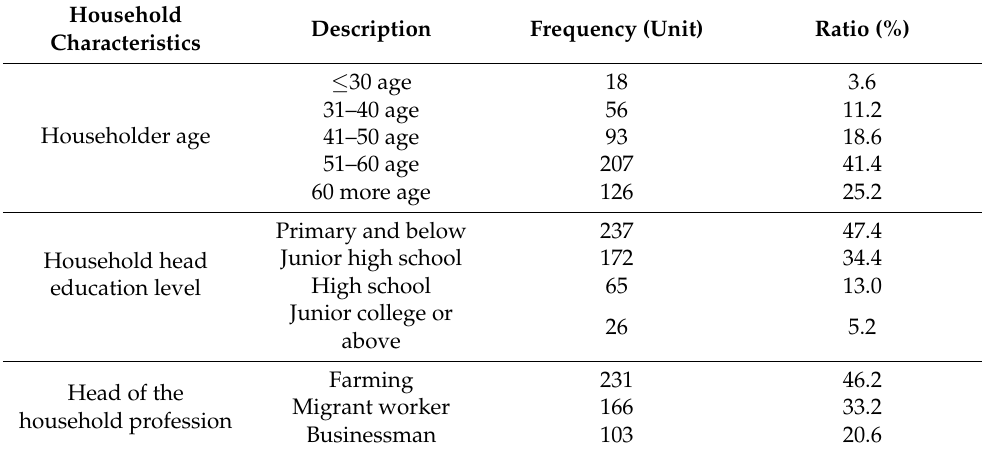
Table 3. Basic characteristics of sample rural